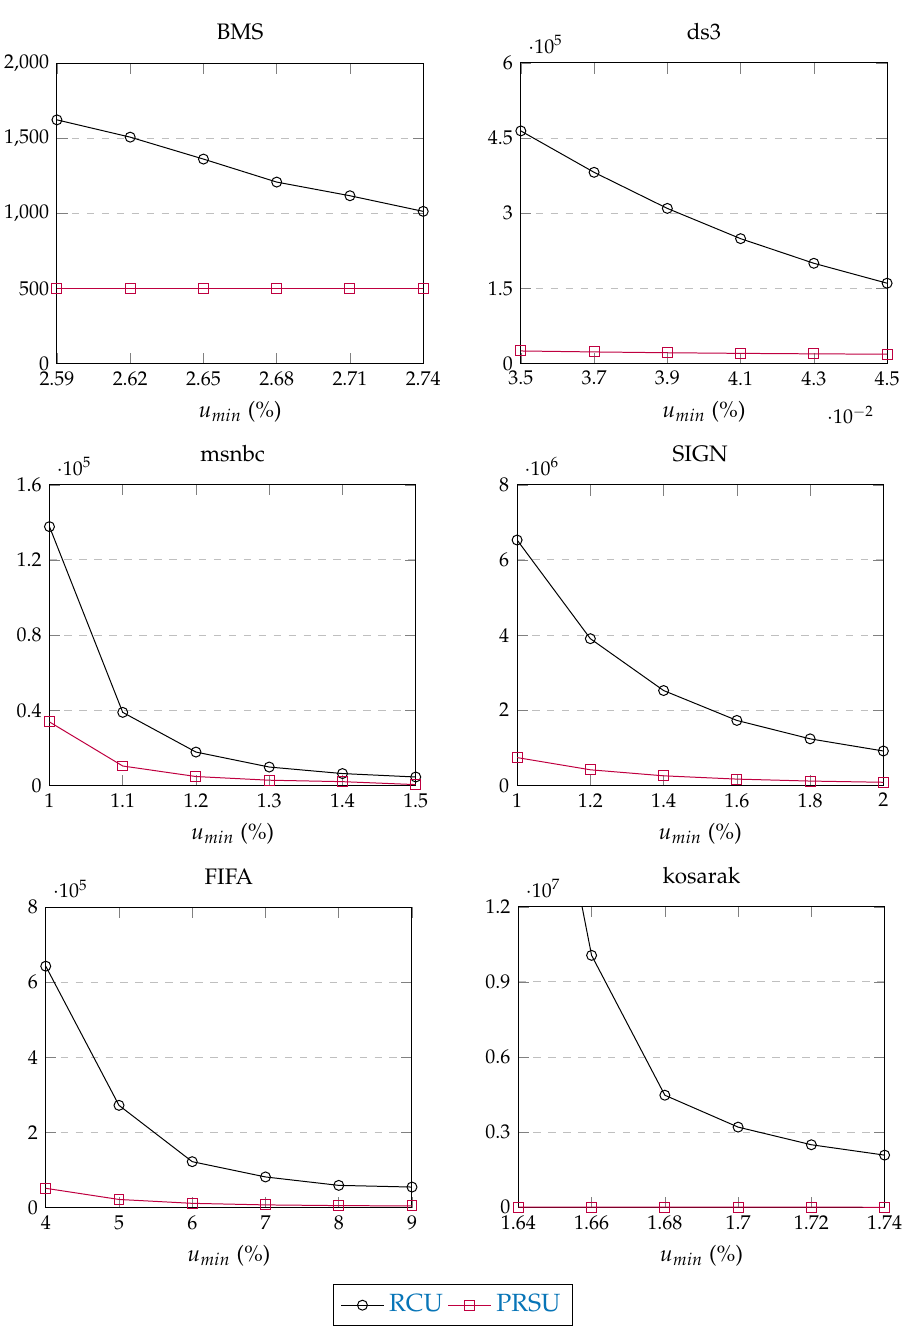
Figure 10. Results of experiment 2: Number of candidate patterns generated by each of the RCU and PRSU methods to identify the full set of high utility sequential